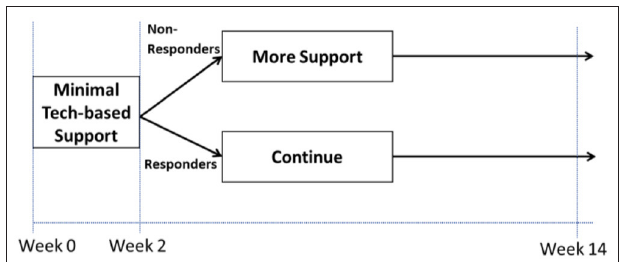
FIGURE 2 | Hypothetical adaptive intervention (Example